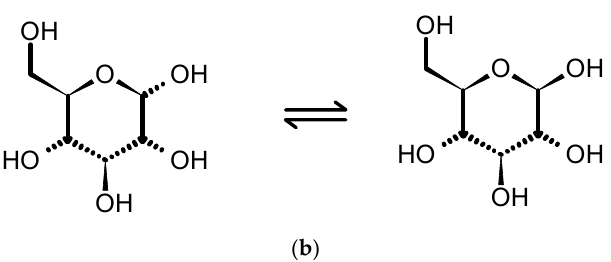
Figure 3. The predominant forms of fructose and glucose in aqueous solution: ( a ) fructose equilibrium 76% β -D-Pyr, 4% α -D-Fur, 20% β -D-Fur; ( b ) glucose equilibrium of 36% α -D-Pyr, 64% β -D-Pyr. Table 3. Characteristic NMR signals of the analytes in spirit